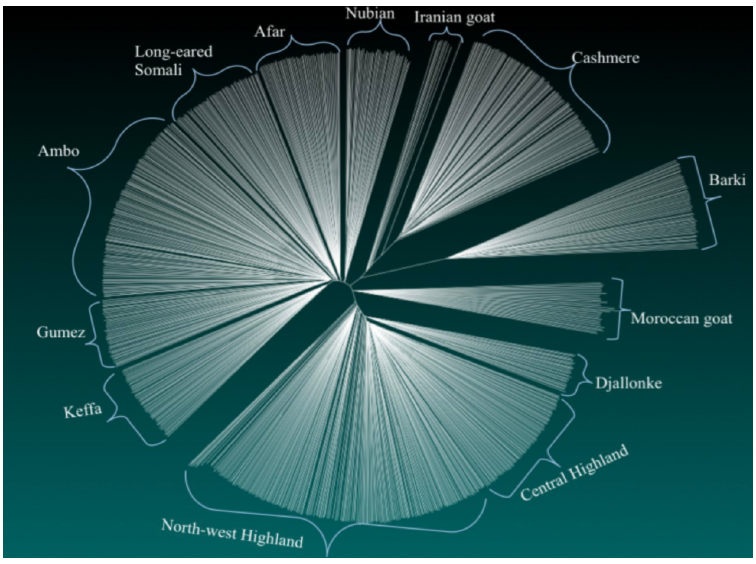
Fig 7. Neighbor-joining (NJ) phylogenetic tree derived from 43421 autosomal single nucleotide polymorphisms (SNPs) of the 13 goat populations analyzed.